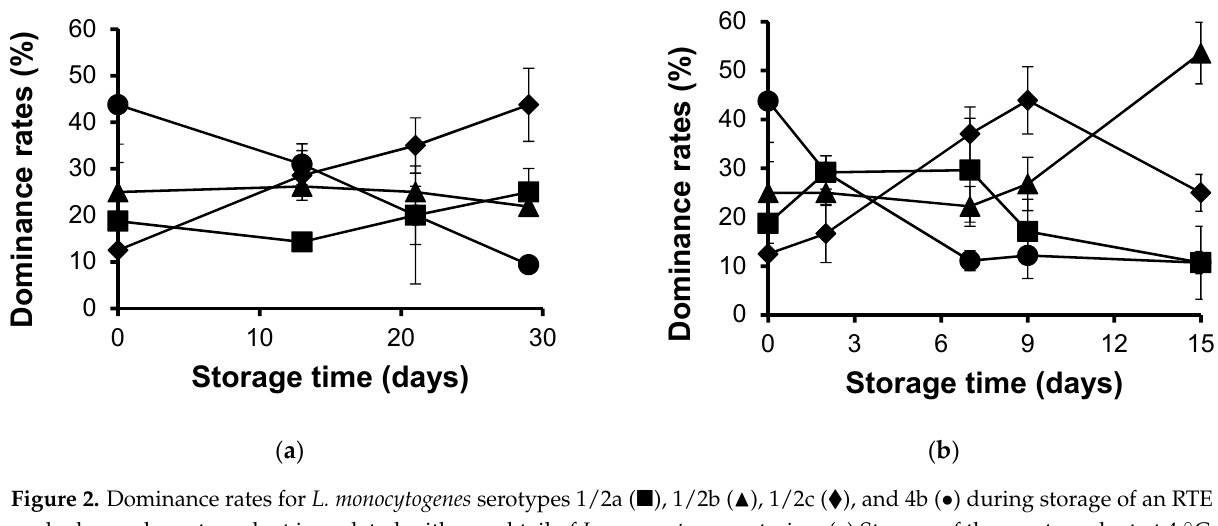
Figure 2. Dominance rates for L. monocytogenes serotypes 1/2a ( ■ ), 1/2b ( ▲ ), 1/2c ( ♦ ), and 4b ( ● ) during storage of an RTE cooked, cured meat product inoculated with a cocktail of L. monocytogenes strains. ( a ) Storage of the meat product at 4 °C; ( b ) storage of meat product at 10 °C. Symbols represent the dominance rates for the respective L. monocytogenes serotype on each sampling day, calculated through Equation (1) (see the text). Serotyped L. monocytogenes strains on each sampling day originate as the result of pathogen isolation from the three replicates performed and the subsequent differentiation by mPCR; the error bars represent the standard deviation of these three